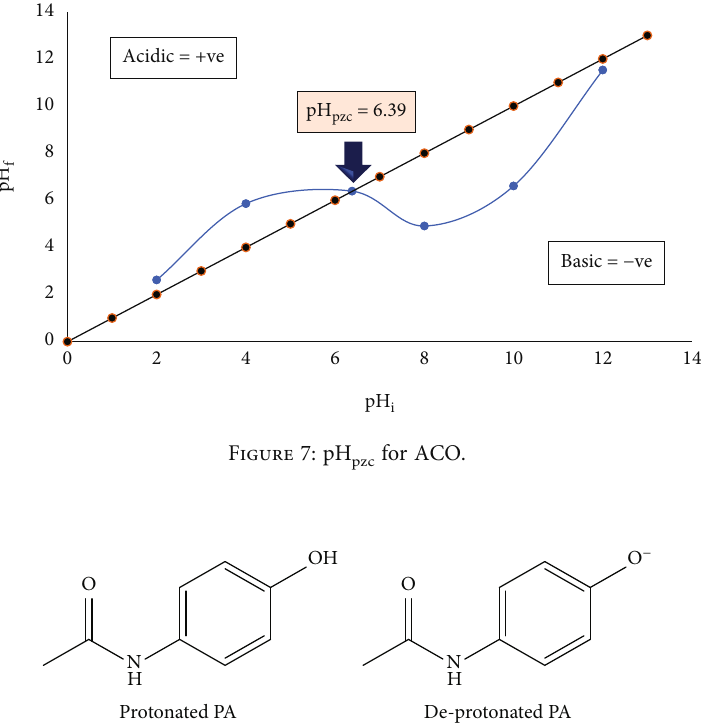
Figure 6: In fl uence of PA initial concentration on the adsorption onto ACO ( dosage = 50 mg , C time = 60 min , and T = 25 ± 1 ° C).